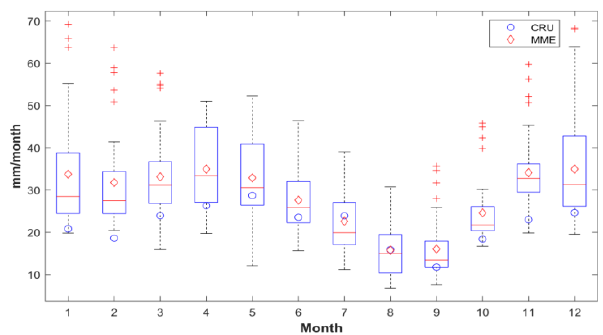
Figure 3. The box-and-whisker plot of monthly precipitation in the Central Asia from 1986 to 2005.